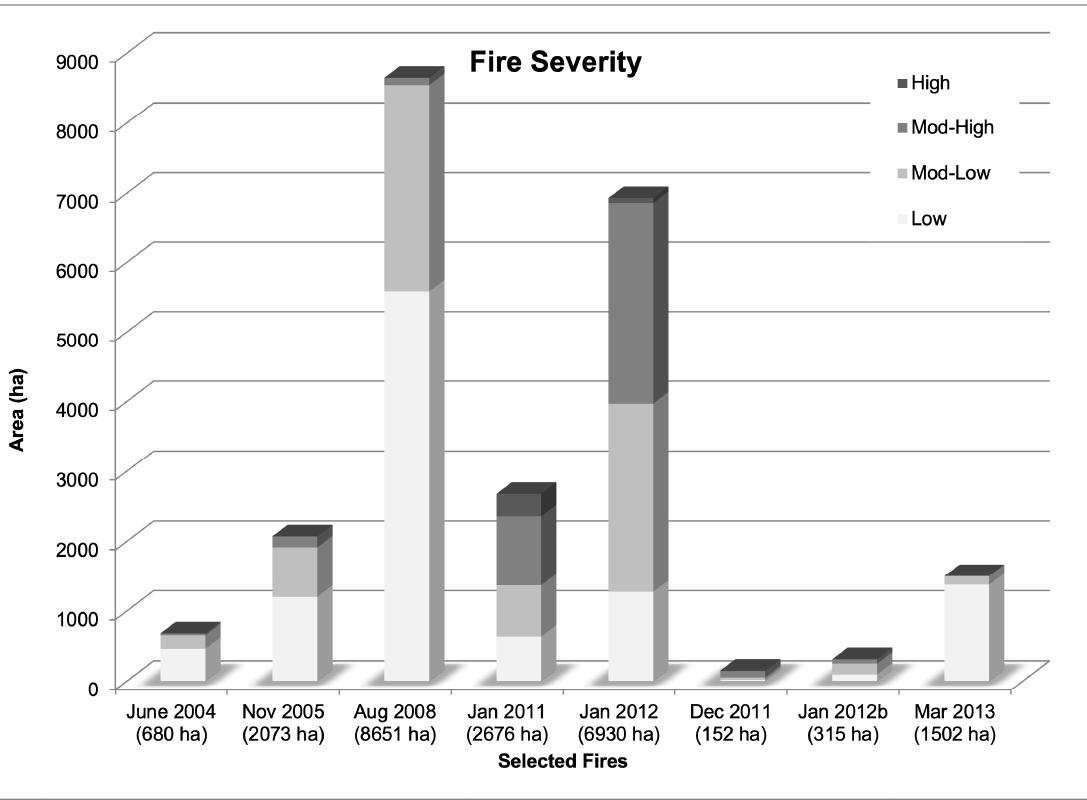
Figure 7. Areas of selected visible burn scars at 30 m resolution with estimated severity measured from ETM+ and OLI dNBR.